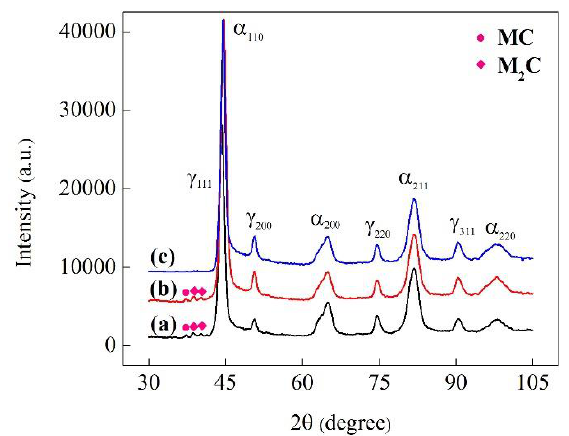
Figure 5. X-ray diffraction patterns of as-quenched specimens: ( a ) Q-T process and austempering Figure 5. X-ray di ff raction patterns of as-quenched specimens: ( a ) Q-T process and austempering process ( b ) without and ( c ) with CR. process ( b ) without and ( c ) with CR.